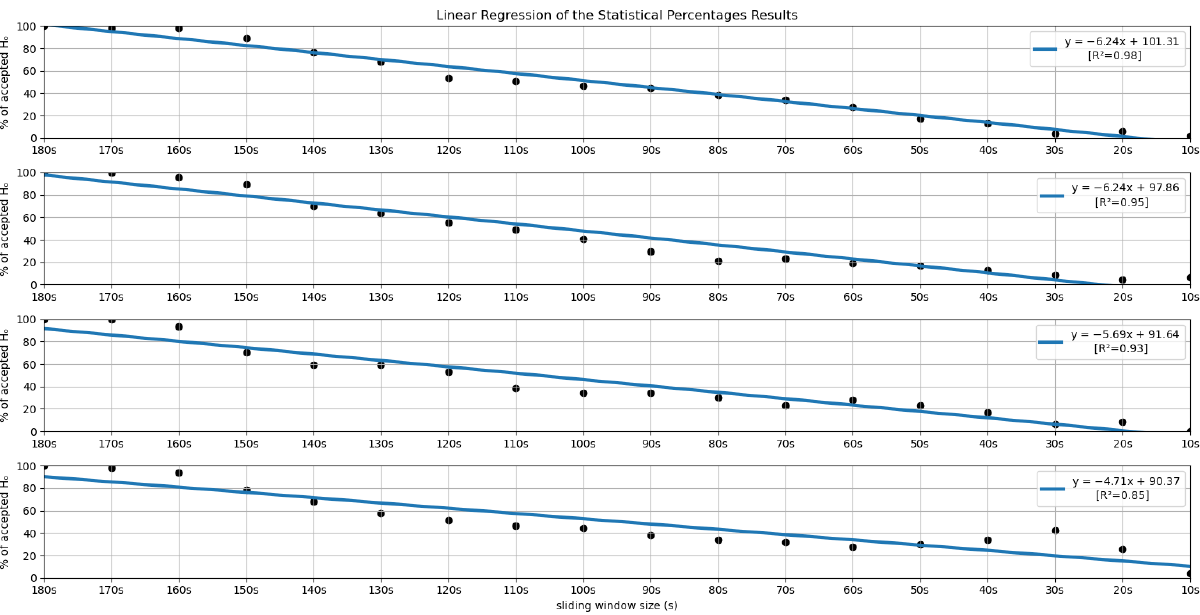
Figure 8. Linear Regressions of the Statistical Percentages obtained for the features LF, HF, LFpeak and